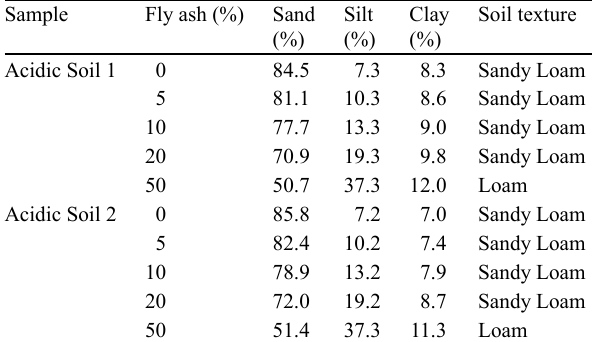
Table 2 Soil compositions of mixed soils Sample